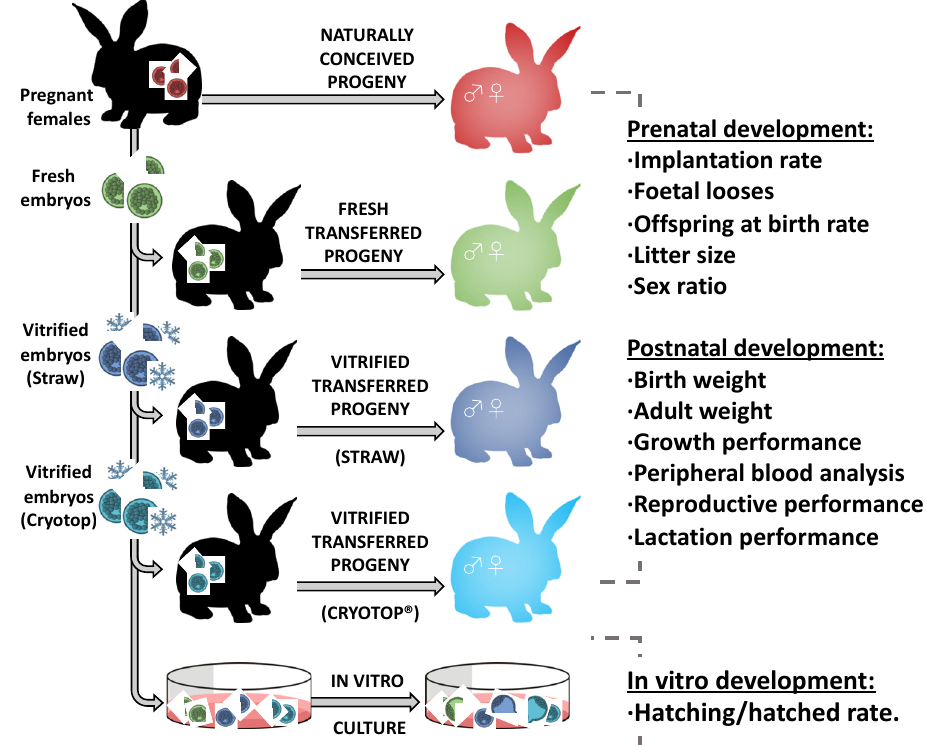
Figure 1. Schematic diagram of the experiment carried out to evaluate the developmental plasticity in response to embryo cryopreservation.